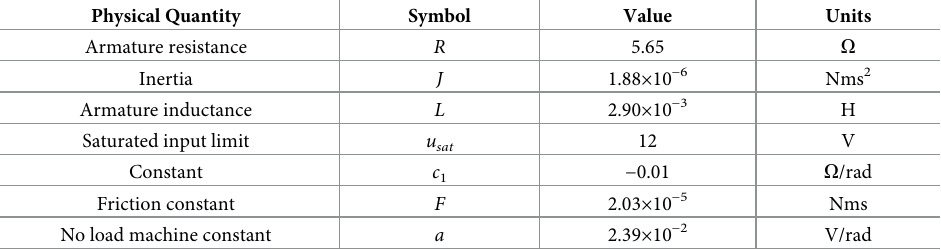
Table 1. Parameters of DC servo